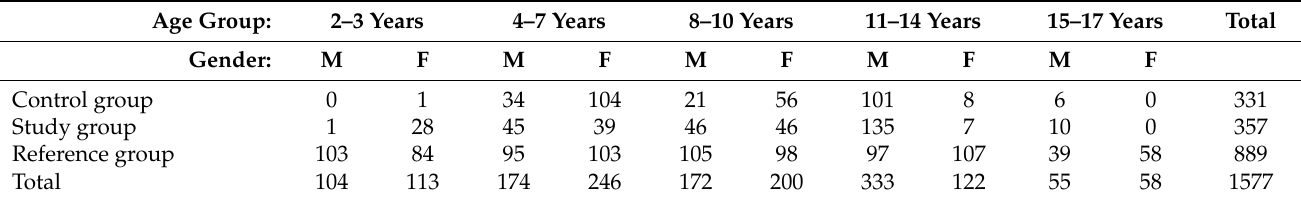
Table 1. Patient distribution according to age group, gender, and group